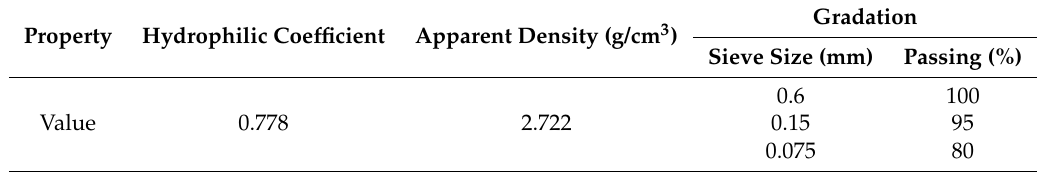
Table 3. Physical properties of mineral powder.